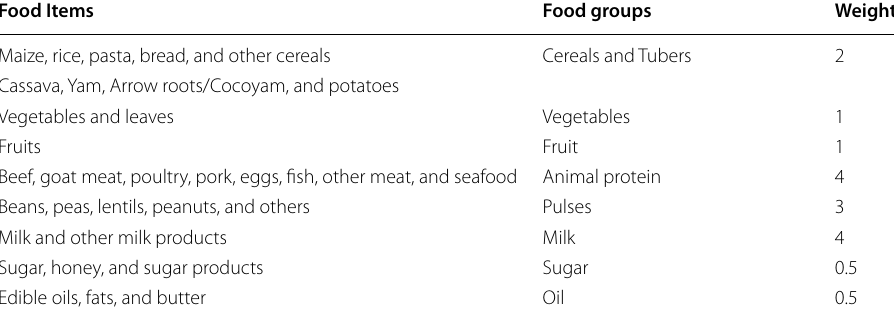
Table 1 Food groups and weight. Source United Nations World Food Programme (2008) Food Items Food groups Weight Maize, rice, pasta, bread, and other cereals Cereals and Tubers 2 Cassava, Yam, Arrow roots/Cocoyam, and potatoes Vegetables and leaves Vegetables Fruits Fruit Beef, goat meat, poultry, pork, eggs, fish, other meat, and seafood Animal protein Beans, peas, lentils, peanuts, and others Milk and other milk products Edible oils, fats, and